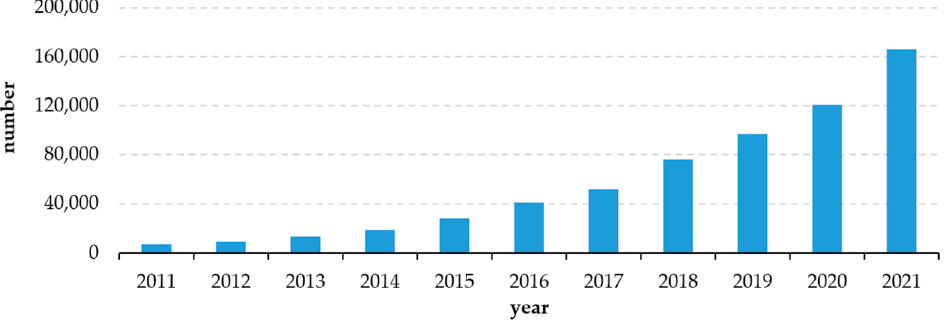
Figure 9. Total number of AF light commercial vehicles (N1) in the European Union.